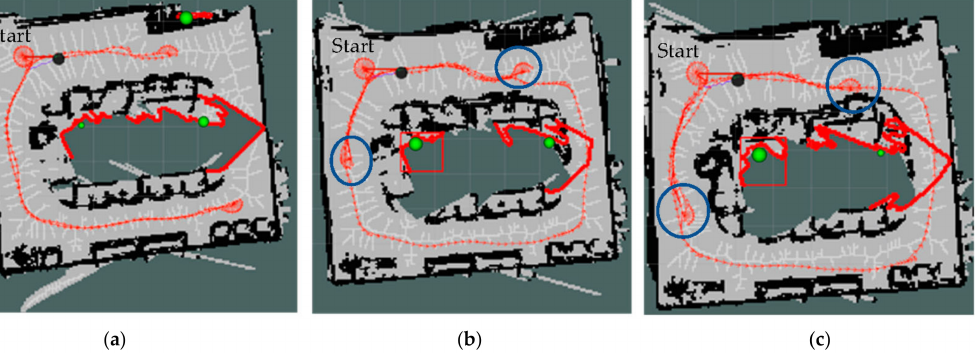
Figure 8. Exploration paths of the moderate-texture environment, the bold red clusters are the ignored inaccessible frontiers, and the green balls represent the centroids of the frontiers. ( a ) D strategy, ( b ) M strategy, and ( c ) M+D